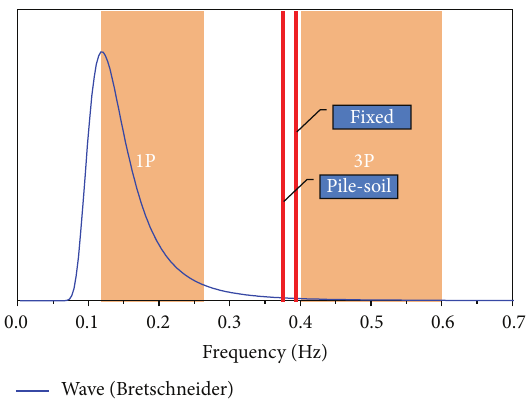
Figure 3: Comparison of hybrid substructure on the spectrum density of wind turbine and wave.